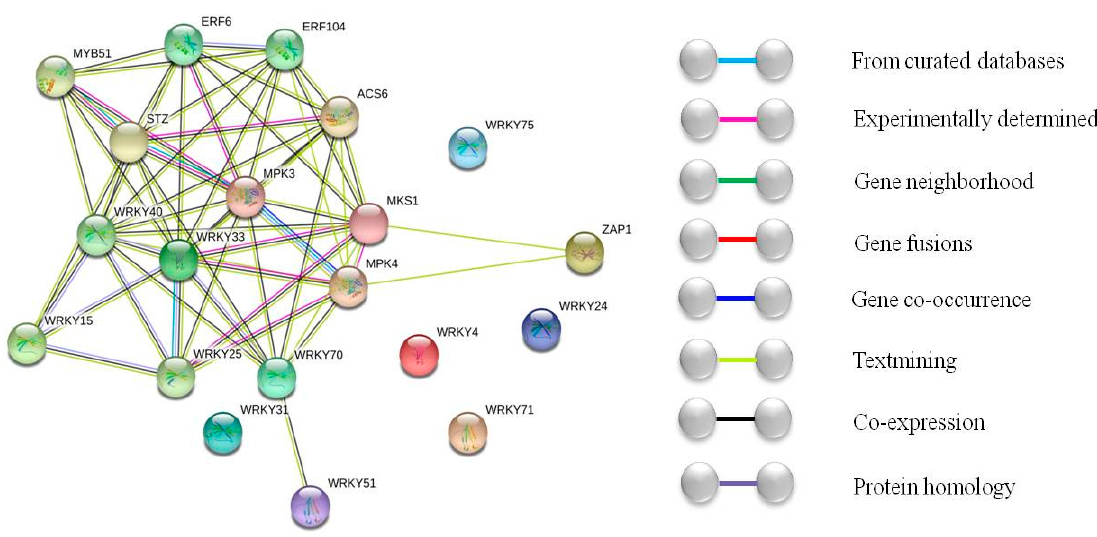
Figure 4. The WRKY protein functional connection network.